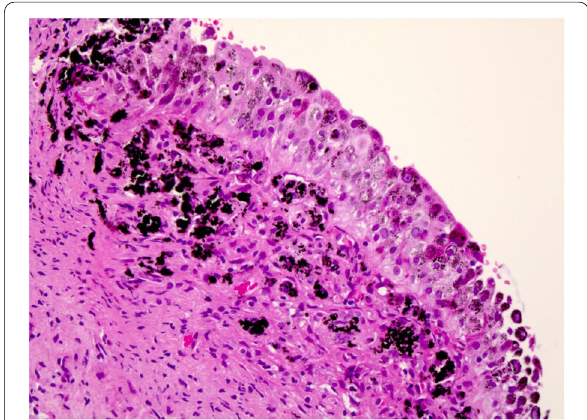
Fig. 2 High‑power view of bladder mucosal biopsy. Melanin is seen in the transitional epithelium and in the fibroblasts in the lamina propria on H&E staining